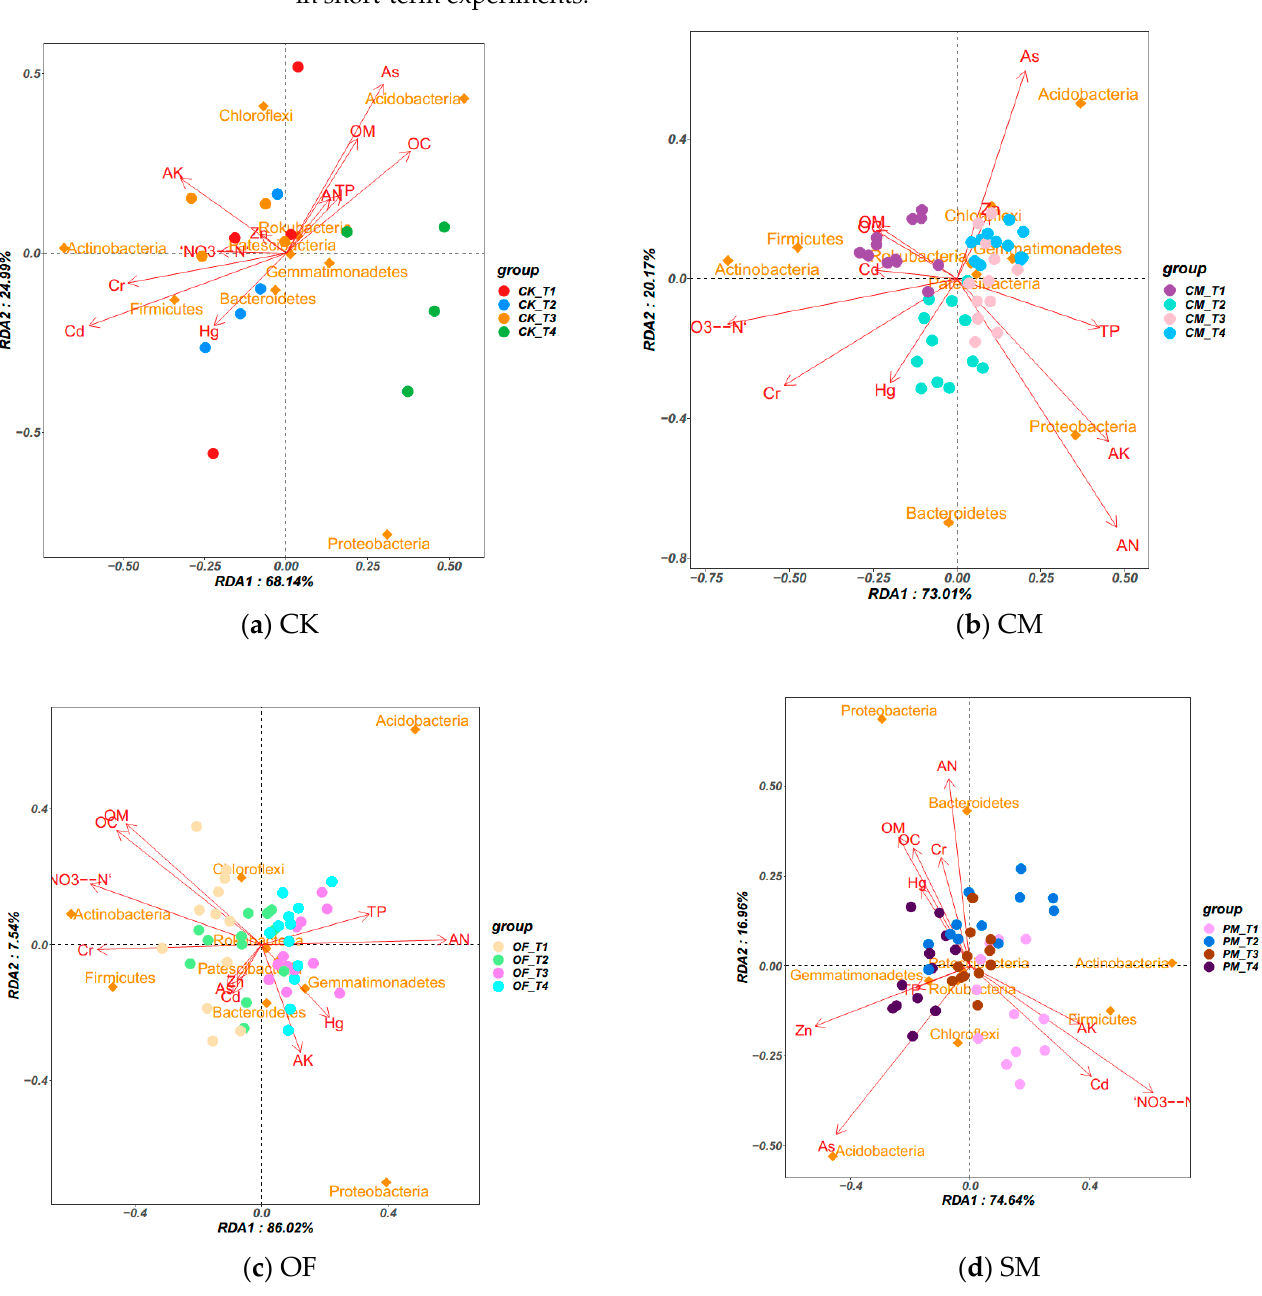
Figure 5. The relationship of environmental factors and microorganisms with different fertilizers